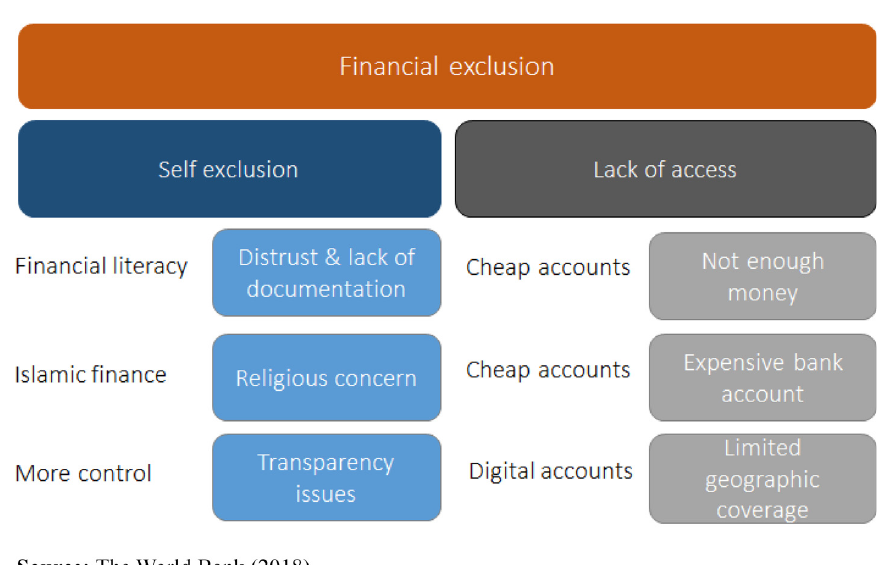
Figure 1. Unbanked people with religious